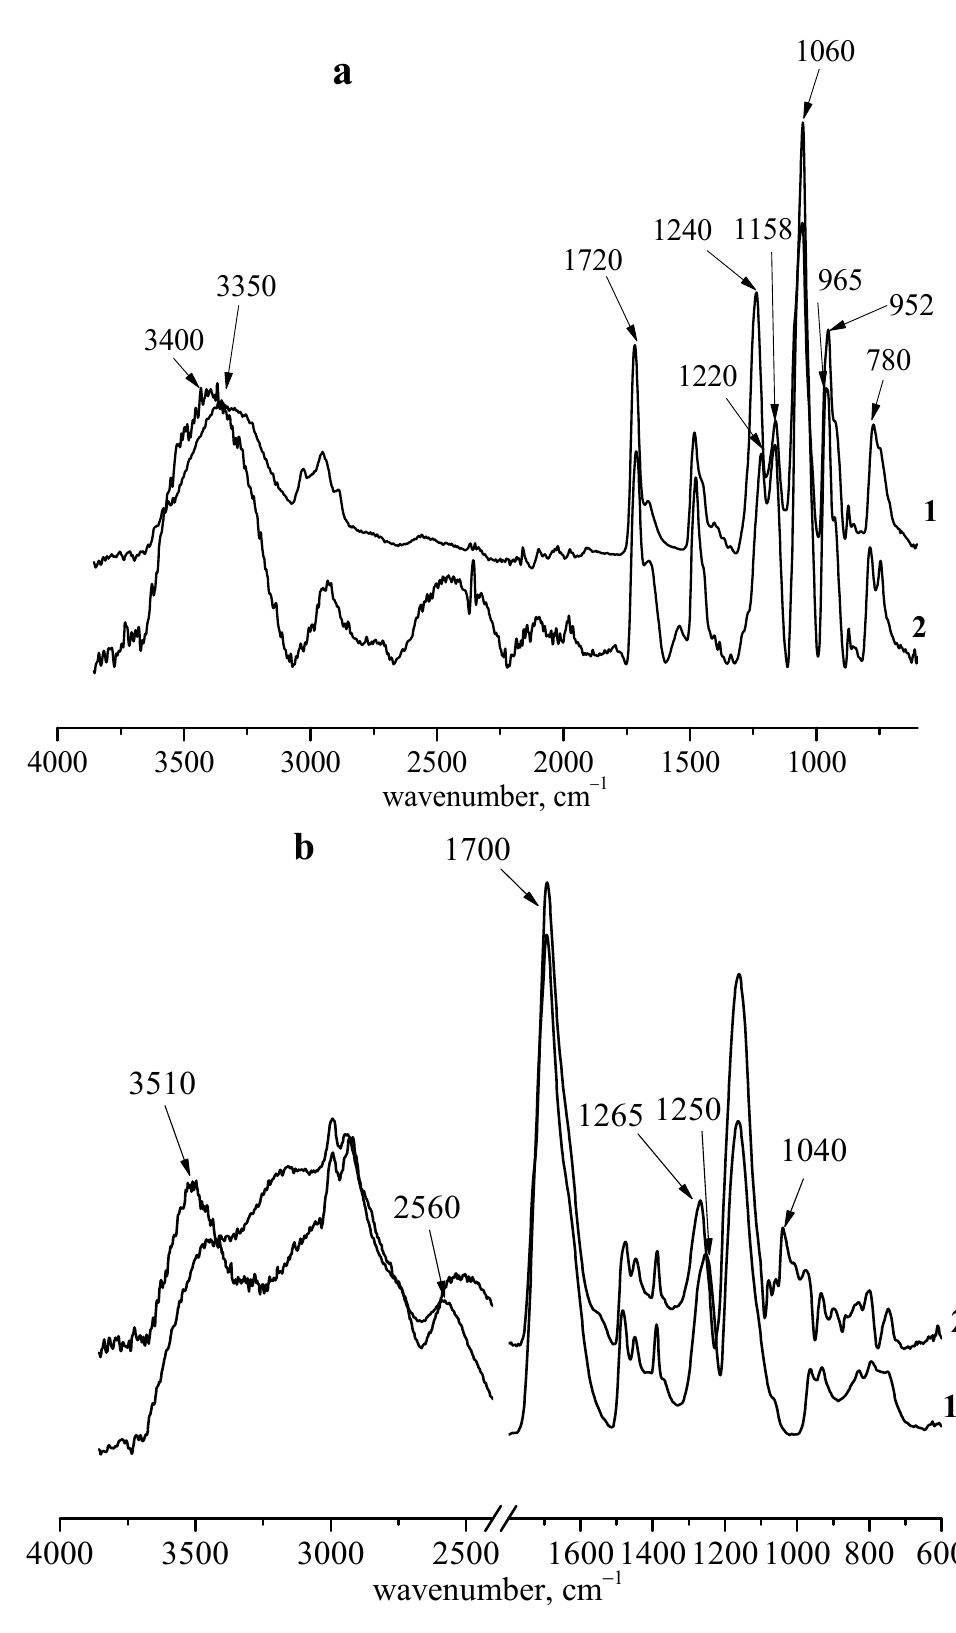
Figure 5. ( a ) IR spectrum of PMPC (1) and the difference spectrum obtained by subtracting the PMAA spectrum from the associate spectrum (2); ( b ) IR spectrum of PMAA (1) and the difference spectrum obtained by subtracting the PMPC spectrum from the associate spectrum (2).